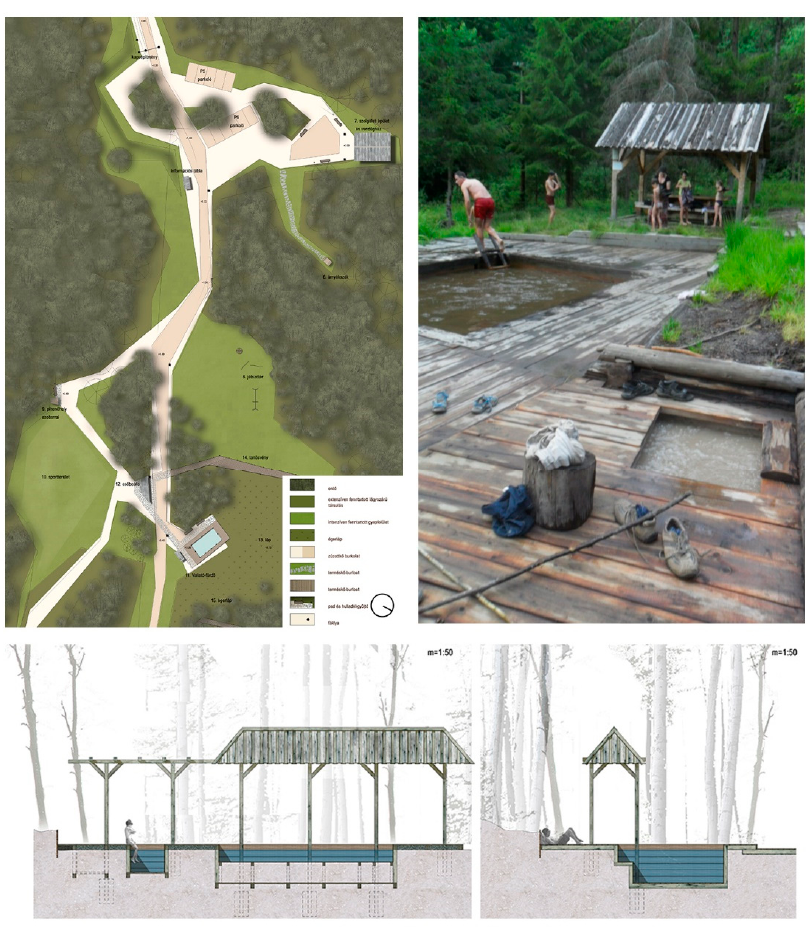
Figure 9. Design details and photo of the renewed site of Hammas bath in Sepsibükszád (Bixad, Romania), 2010. Design by Máté Sárospataki and János Hómann.